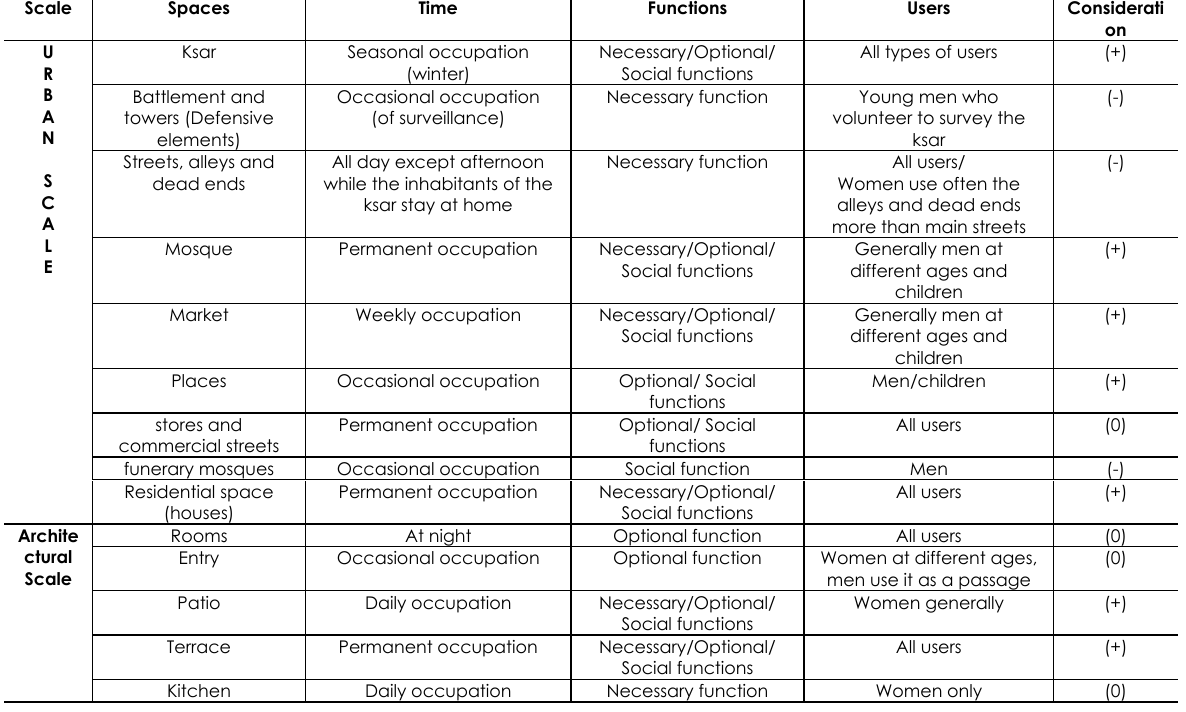
Table 2: The analysis of the multifunctionality in Beni Isguen according to their aspects. Scale Spaces